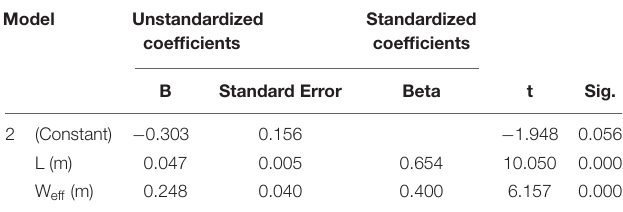
TABLE 5 | Regression coefficients for two independent